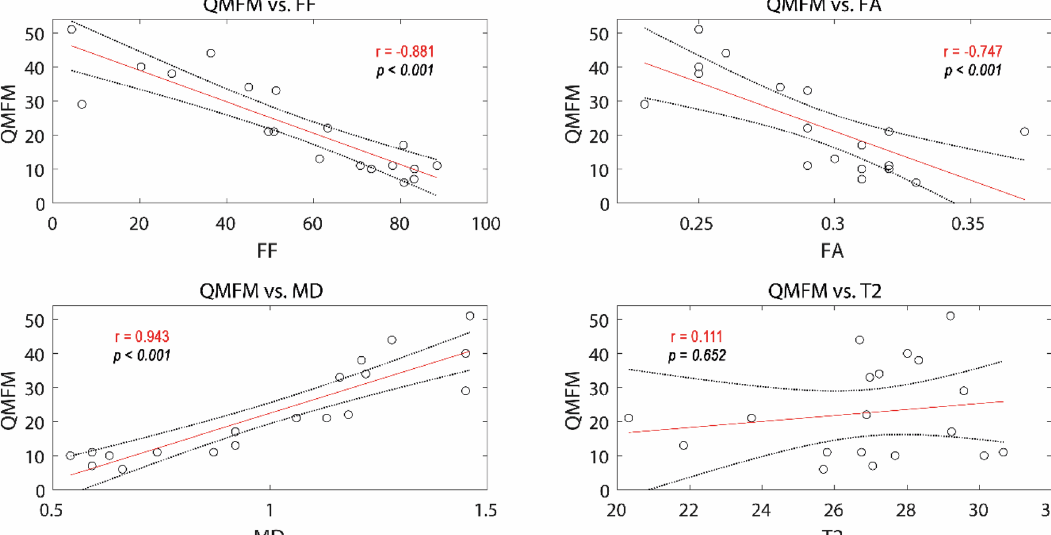
Figure4. qMRI data and QMFM correlations. Spearman rank correlation coefficients (r) of qMRI values fat fraction (FF), fractional anisotropy (FA), mean diffusivity (MD), and T2 time of all thigh muscles to Quick Motor Function Measure (QMFM). Regression lines are coloured in red, 95%-confidence intervals are coloured in